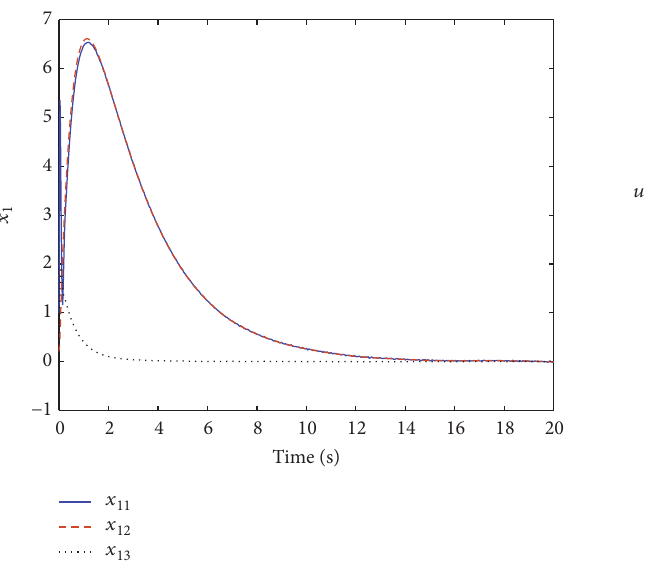
Figure 4: Rotor system state response 𝑥 1 .